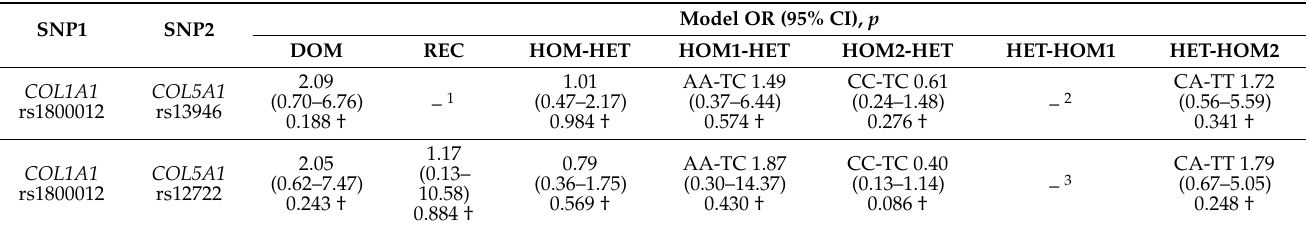
Table 6. Association of the COL1A1 × COL5A1 interaction with injury